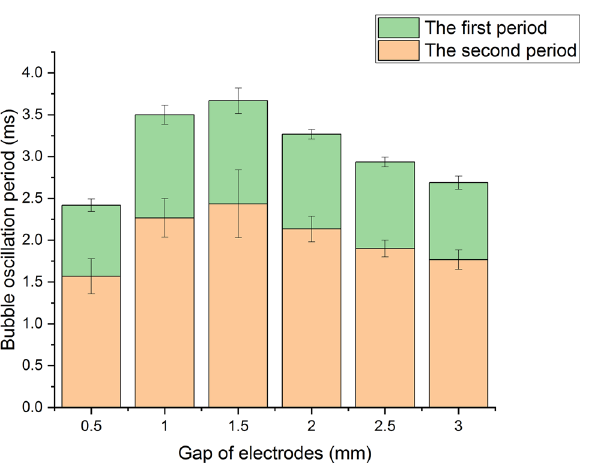
Figure 8. The bubble oscillation periods versus